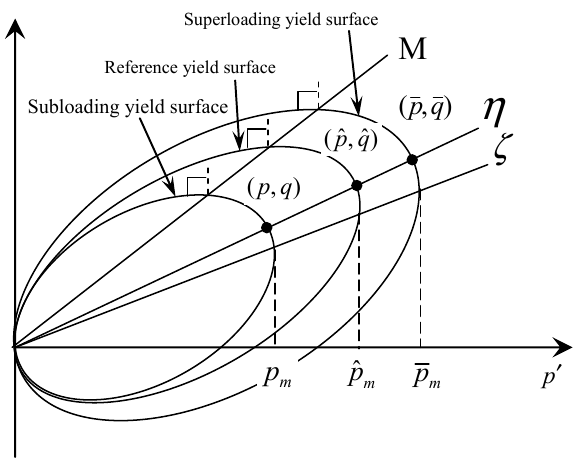
Figure 1. Subloading, reference and superloading yield surfaces.